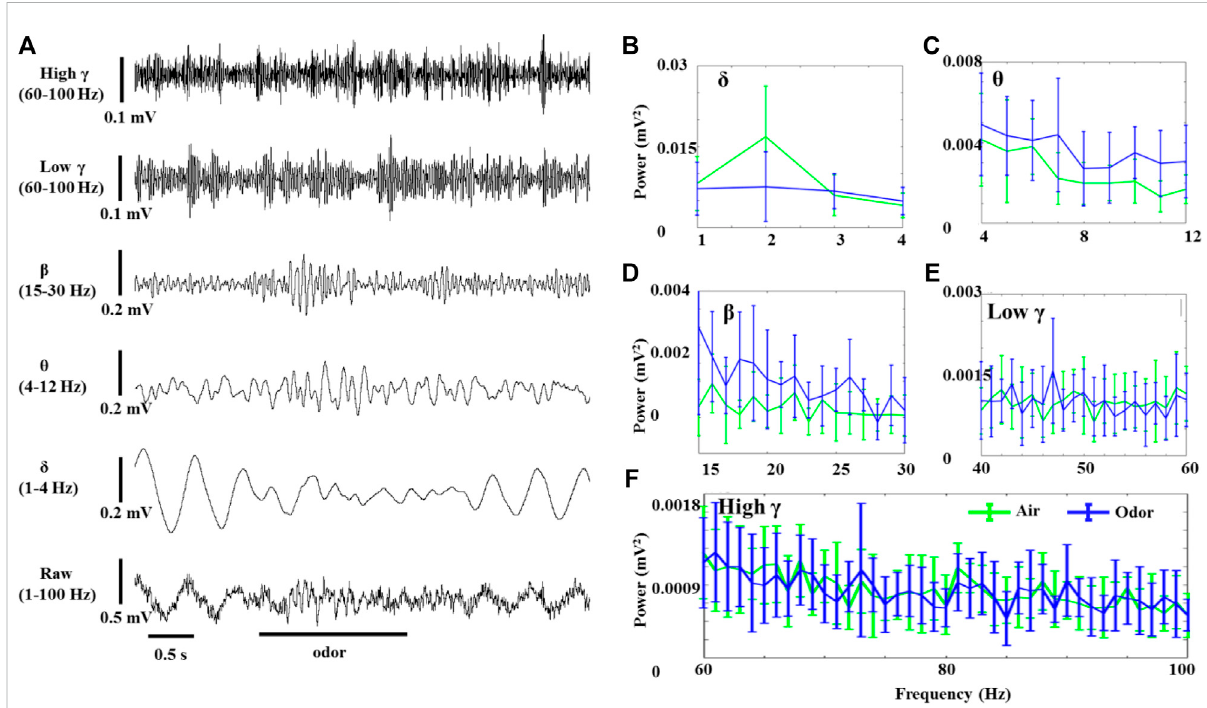
FIGURE 2 Odor-evoked LFP (1 – 100 Hz) responses in the OB of anesthetized rats. (A) Typical OB LFP traces recorded under nonanoic acid (NA) stimulation.Shownaretheband-pass fi lteredtracesof δ (1 ‒ 4 Hz), β (15 – 30 Hz),low γ (40 – 60 Hz),andhigh γ (60 – 100 Hz)activity,aswellasfullband LFP (1 – 100 Hz). The Mean fast Fourier transform (FFT) power spectrum showing the distribution of energy from the δ - (B) , θ - (C) , β - (D) , low γ - (E) , and high γ -bands (F) across three rats under air (green line) and NA (blue line) stimulation. The trial-averaged data are presented as the mean ± SEM, n = 12, 4 trials per